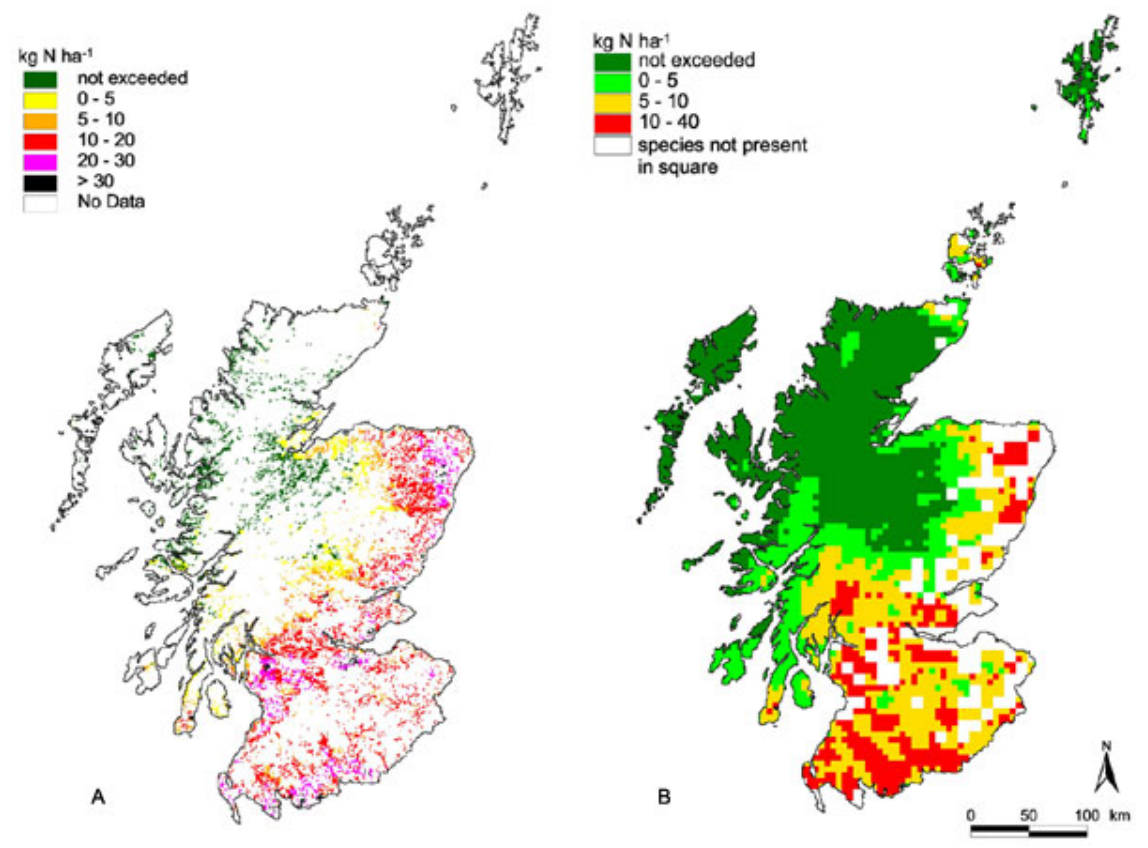
FIGURE 8. Modelled exceedance of the critical load for nitrogen eutrophication for (A) deciduous woodland and (B) sundew ( D. rotundifolia ). For coniferous woodland, a mass balance calculation is applied, while for Drosera , an empirical critical load of 10 kg N ha –1 year –1 has been set. For the deciduous woodland map, “no data” refers to areas with less than 5% cover of deciduous